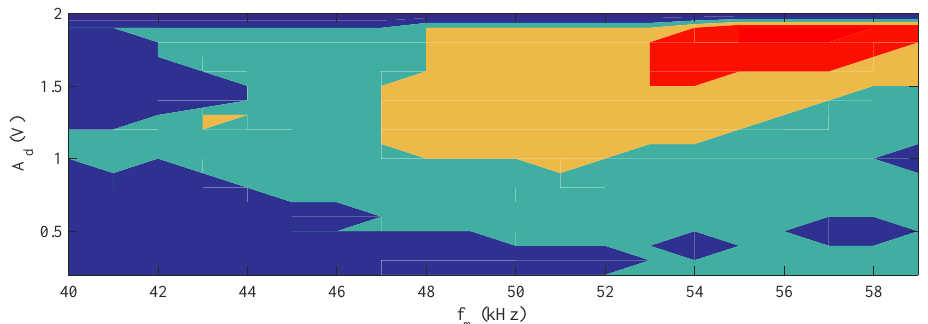
Figure 8. Map resulting from the discretization of the periods of the experimental scheme. The red region corresponds to P 4 , the yellow region to P 3 , the light blue region to P 2 , and the dark blue region to P 1